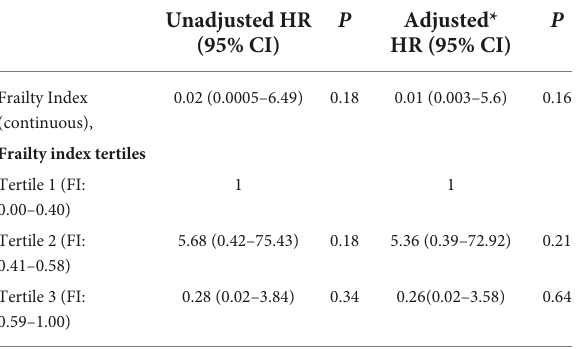
TABLE 3 Relationship between frailty index and